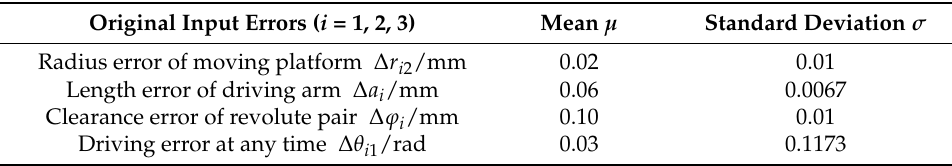
Table 2. Mean and standard deviation of original input